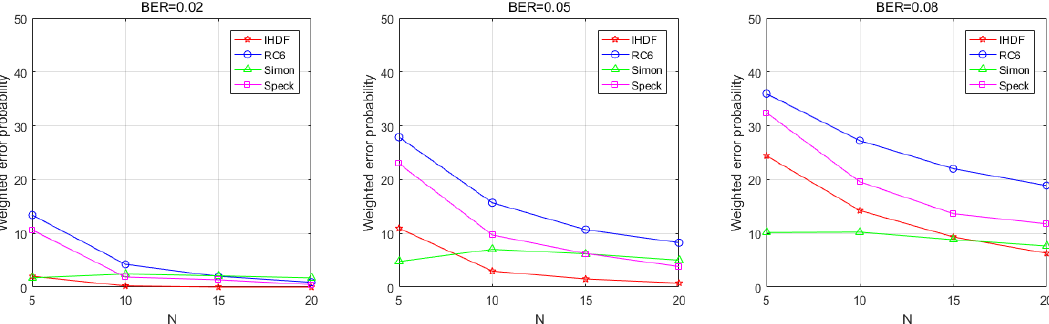
Figure 9. The weighted error probabilities at the AFC with an increasing number of sensors in the physical environment.